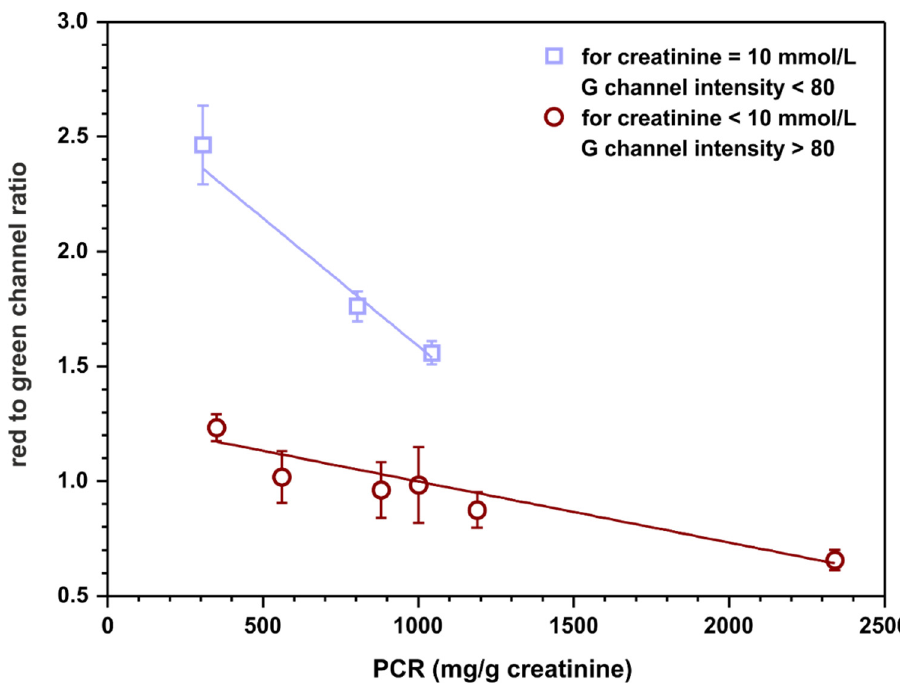
Figure 7. Semiquantitative, calibration-free, protein to creatinine ratio estimation. The value on ordinate represents the ratio of red channel intensity taken from the protein detection zone to green channel intensity measured in the creatinine detection zone. The top linear fit ( y = − 0.0011 + 2.7, R 2 = 0.930) represents samples with 10 mmol·L − 1 of creatinine while the bottom one ( y = − 0.0003 + 1.3, R 2 = 0.939) represents samples with 7.5 and 4 mmol·L − 1 of creatinine.